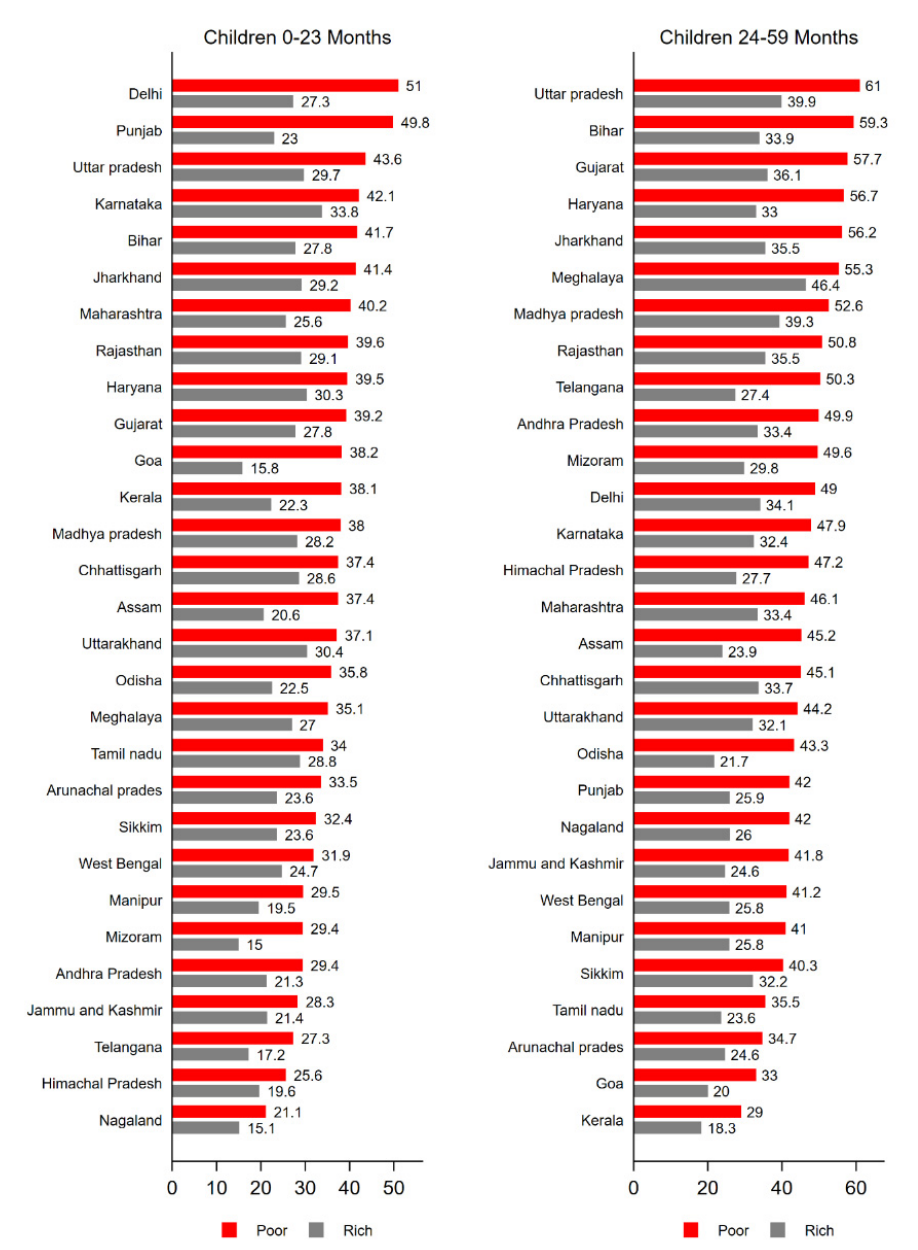
Figure 1. Prevalence of child stunting among children by age groups and wealth quintiles across the states, India, NFHS, 2016.